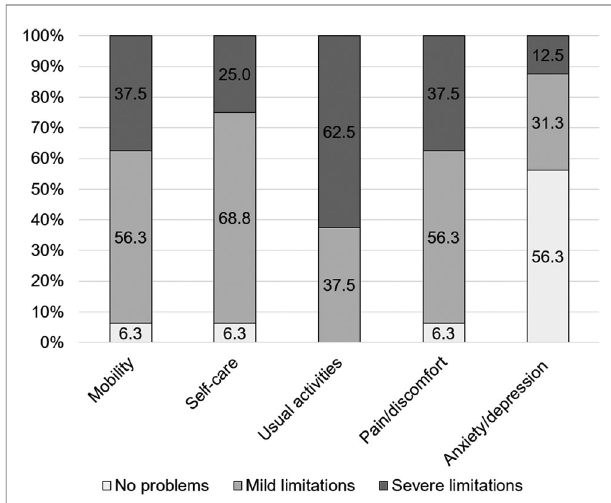
FIGURE 5 | Percentage of patients showing limitations in the mobility, self- care, usual activity, pain/discomfort, and anxiety/depression of the EQ-5D subdimensions. The share of mild limitations is shown in gray, the share of severe limitations is in dark gray, and the share of no limitations is in light gray.